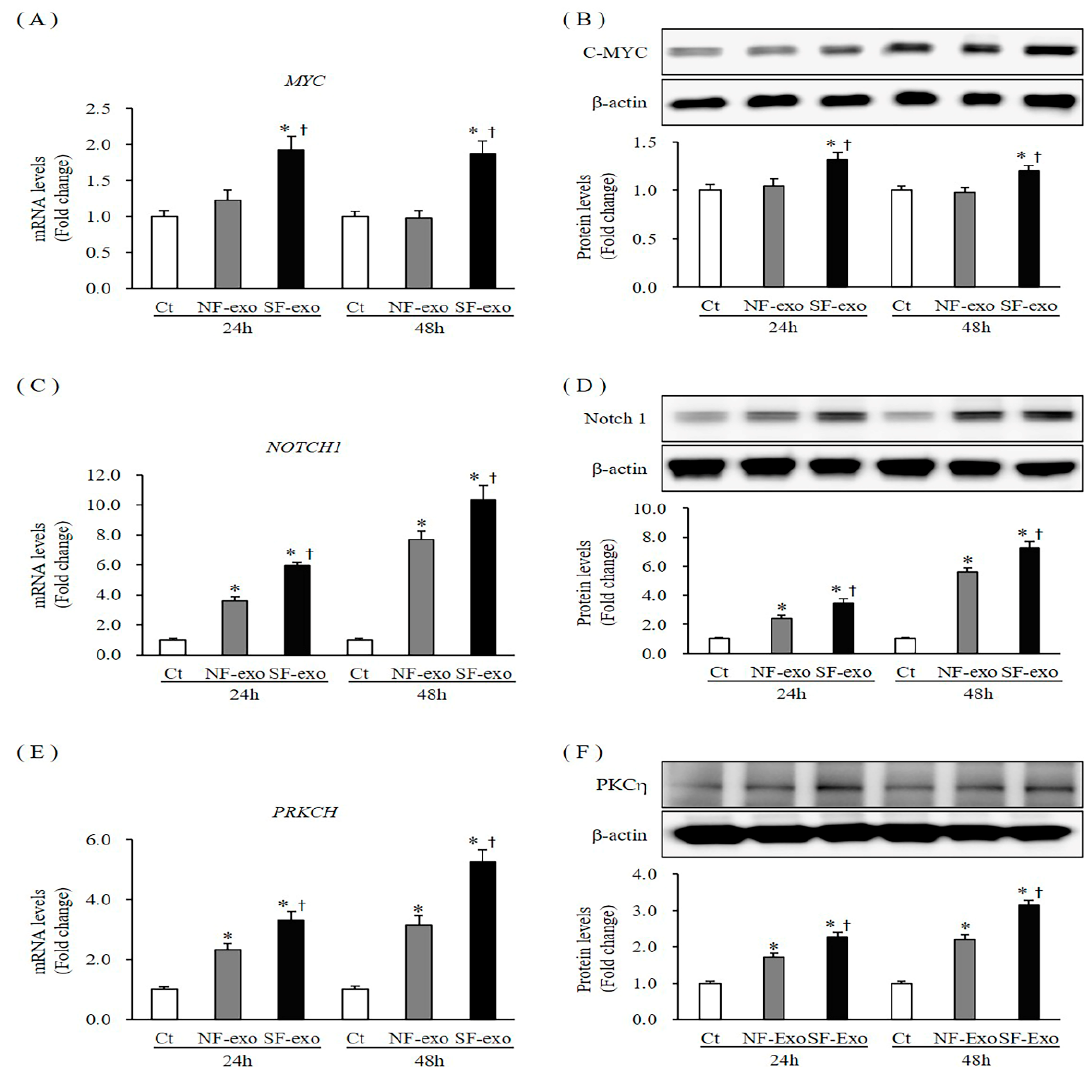
Figure 7. Expression of the regulators of the cyclin-dependent kinase inhibitor in NHKs after NF- and HTSF-exosome treatment. The mRNA and protein expression of C-MYC ( A , B ) in NHKs increased significantly at 24 and 48 h after treatment with 100 µg/mL HTSF-exosomes but remained unchanged after treatment with NF-exosomes, compared with that in the control cells. The mRNA and protein expression of Notch1 ( C , D ) and PKC η ( E , F ) increased significantly at 24 and 48 h after treatment with 100 µg/mL NF- and HTSF-exosomes, compared with that in the control cells. The mRNA and protein expression of Notch1 and PKC η increased to a greater degree with HTSF-exosome treatment than with NF-exosome treatment. * p < 0.05 for NF- or HTSF- exosome-treated cells versus the corresponding matched control cells. † p < 0.05 for HTSF-exosome-treated cells versus NF-exosome-treated cells. Data represent the mean ± SD; n = 4. Ct, DPBS-treated control cells; NHK, normal human keratinocytes; NF, normal tissue-derived fibroblasts; HTSF, hypertrophic scar tissue-derived